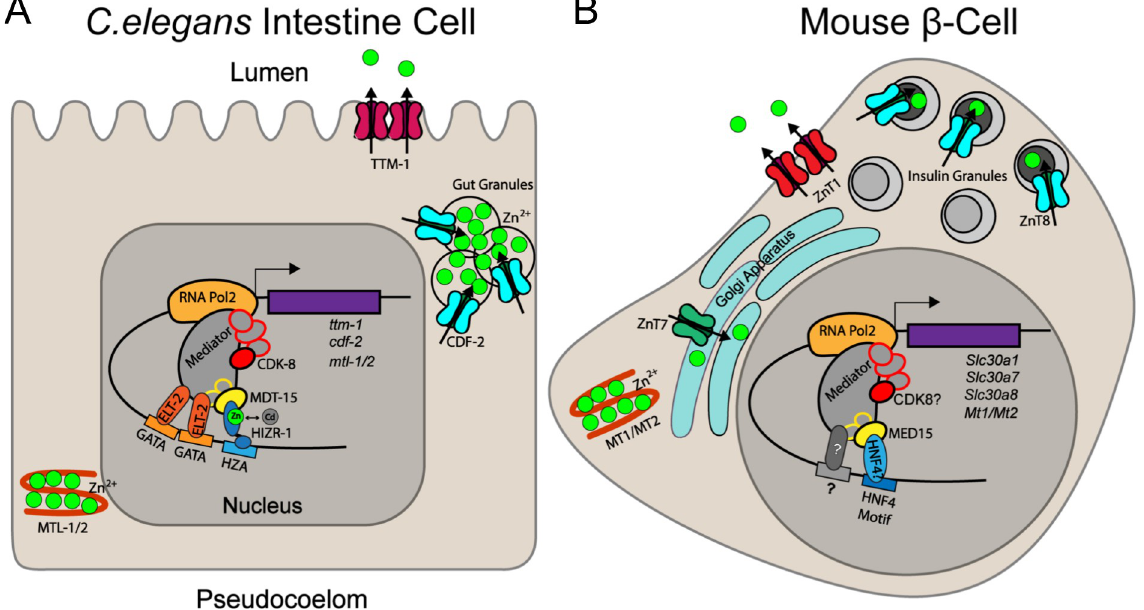
Fig 8. Model of MDT-15 and MED15 driven gene regulation in response to cadmium or high levels of zinc. [A] In the C . elegans intestinal cells, MDT-15 cooperates with HIZR-1 bound to the HZA element to induce the metal-sequestering metallothioneins ( mtl-1 and -2 ) and the transporter cdf-2 , which shuttles zinc into storage granules; excess cadmium is likely detoxified through similar mechanisms. ELT-2 may also contact Mediator to regulate cadmium or zinc responsive transcription. [B] In the mouse pancreatic β -cells, Med15 regulates the expression of genes such as Slc30a8/ZnT8 in response to elevated zinc levels, possibly via HNF4, or other, Mediator contacting transcription